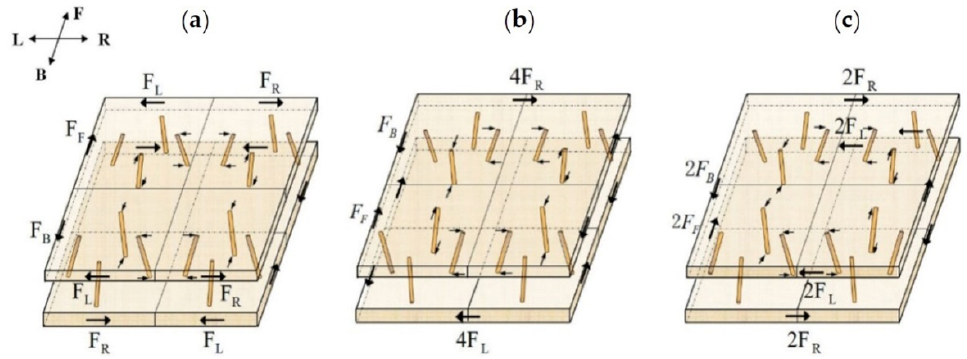
Figure 11. Force analysis of panels. ( a ) I type specimen. ( b ) II type specimen. ( c ) III type specimen. In Figure 11, the forces relationships are shown in Equation (22).